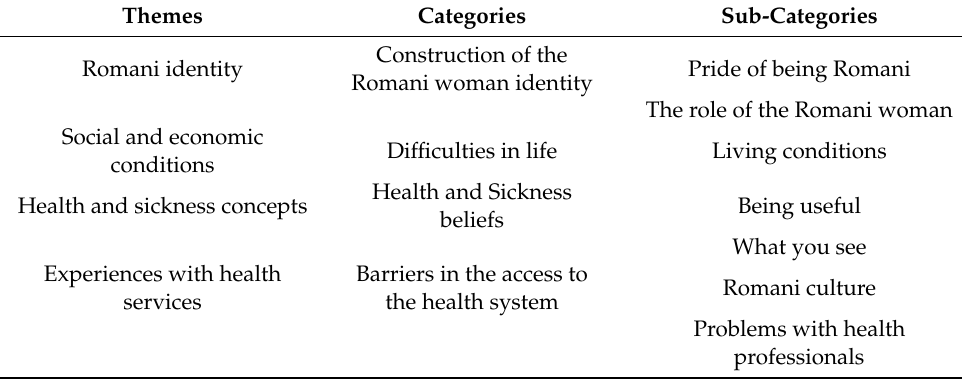
Table 2. Table of Thematic